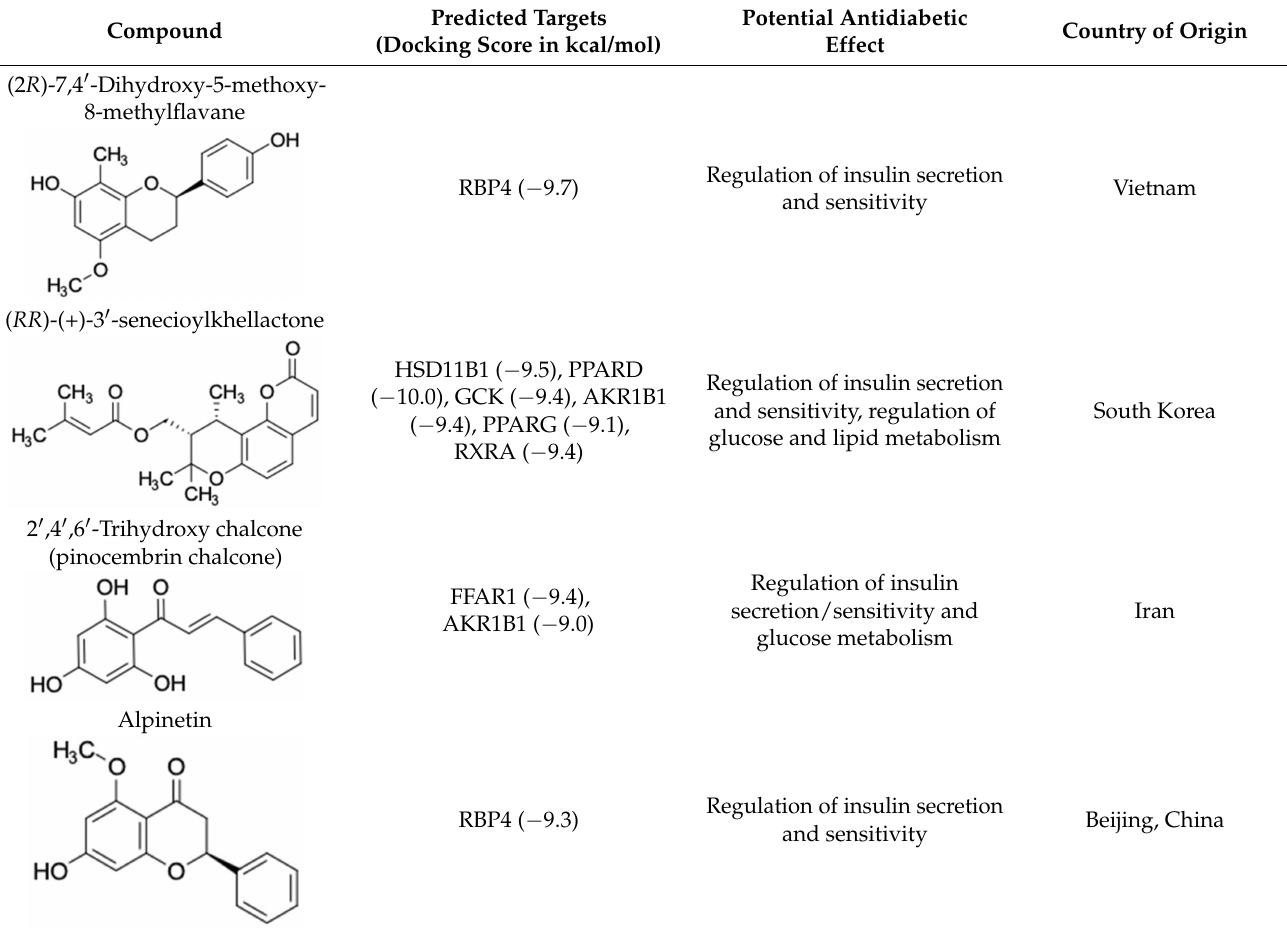
Table 7. Potential compounds of sian propolis with favorable ADMET